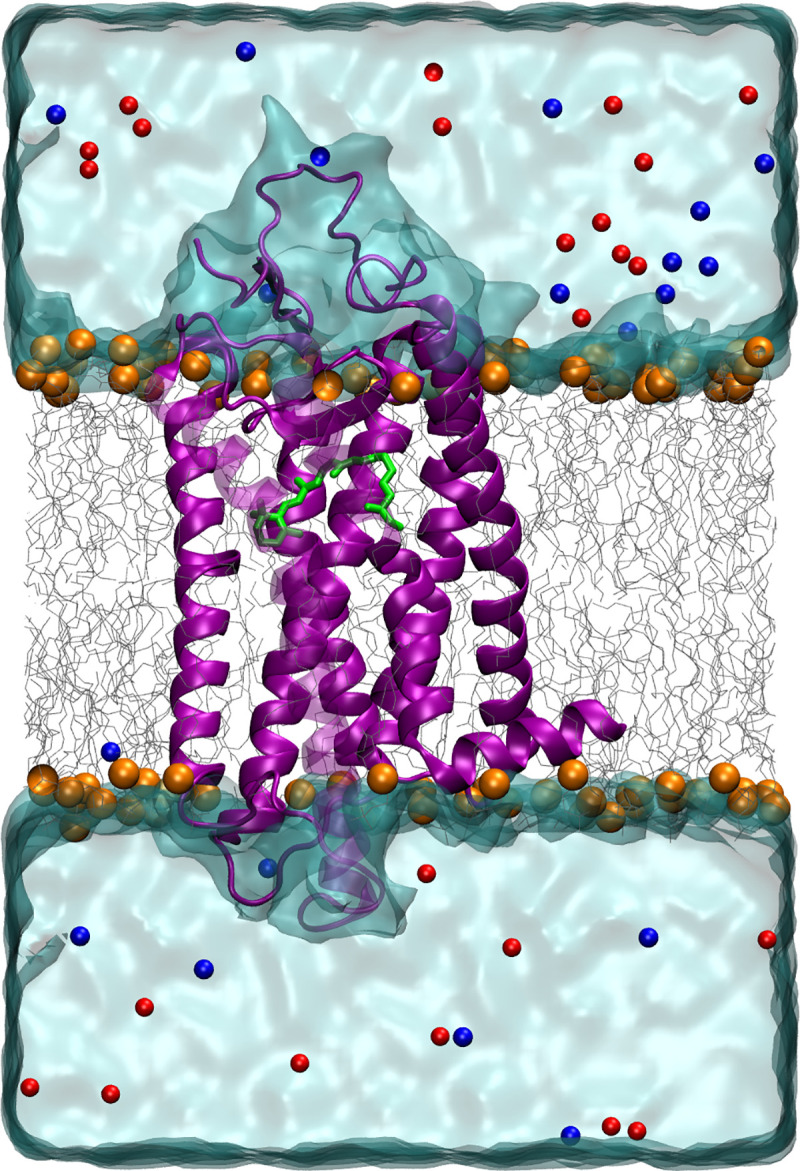
A representative 3D structure of Sws2 cone opsin (λmax values <430 nm) homology structure (violet) with the chromophore (green) bound covalently to K296 of the opsin protein.It is inserted in a phospholipid bilayer (gray, carbon atoms; orange, phosphorus atoms) and surrounded by water molecules (light blue). Blue and red spheres indicate positive and negative counter ions, respectively.